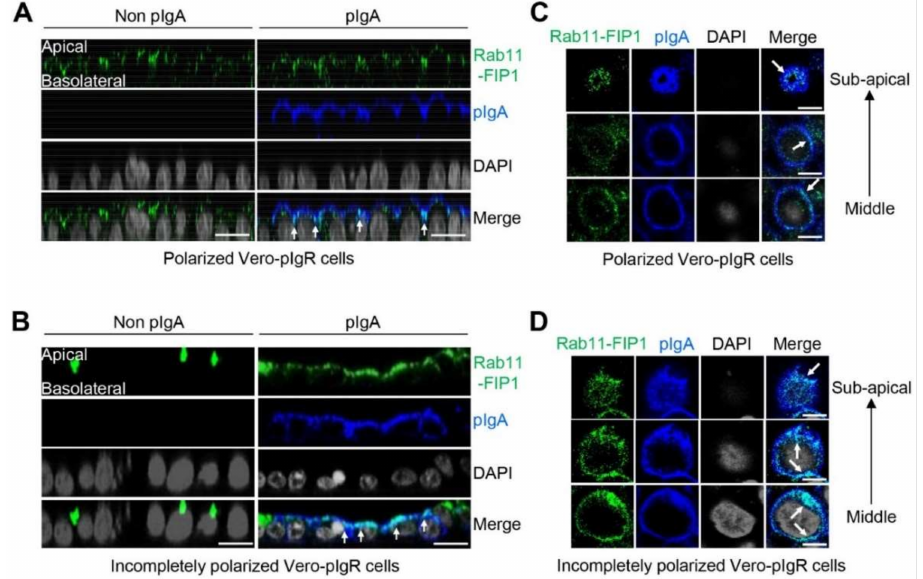
Figure 2. Rab11 − FIP1 colocalizes with pIgA during pIgA transcytosis. ( A , B ) Analysis of Rab11 − FIP1 distribution in polarized and incompletely polarized cells. Vero − pIgR cells (1 × 10 5 ) were grown on 12 mm diameter Transwell (0.4 µ m pore) for 6 days ( A ). Vero − pIgR cells (1 × 10 5 ) were grown on 12 mm diameter Transwell (0.4 µ m pore) for 3 days ( B ). An amount of 20 µ g pIgA was added or not added to the basal chamber for 1 h. The cells were fixed with 4% paraformaldehyde and stained with the indicated antibodies before observation by confocal microscopy. Scale bar: 20 µ m. ( C , D ) Analysis of Rab11 − FIP1 and pIgA distribution at different regions of Vero − pIgR cells. Vero − pIgR cells (1 × 10 5 ) were grown on Transwell for 6 days ( C ). Vero − pIgR cells (1 × 10 5 ) were grown on 12 mm diameter Transwell (0.4 µ m pore) for 3 days ( D ). An amount of 20 µ g pIgA was added to the basal chamber for 1 h. Subsequently, cells were fixed with 4% paraformaldehyde and stained with the indicated antibodies before observation by confocal microscopy. Cells in the same field of vision were successively observed from the middle region to subapical region. Scale bar: 10 µ m. Data of ( A – D ) are representative of three independent